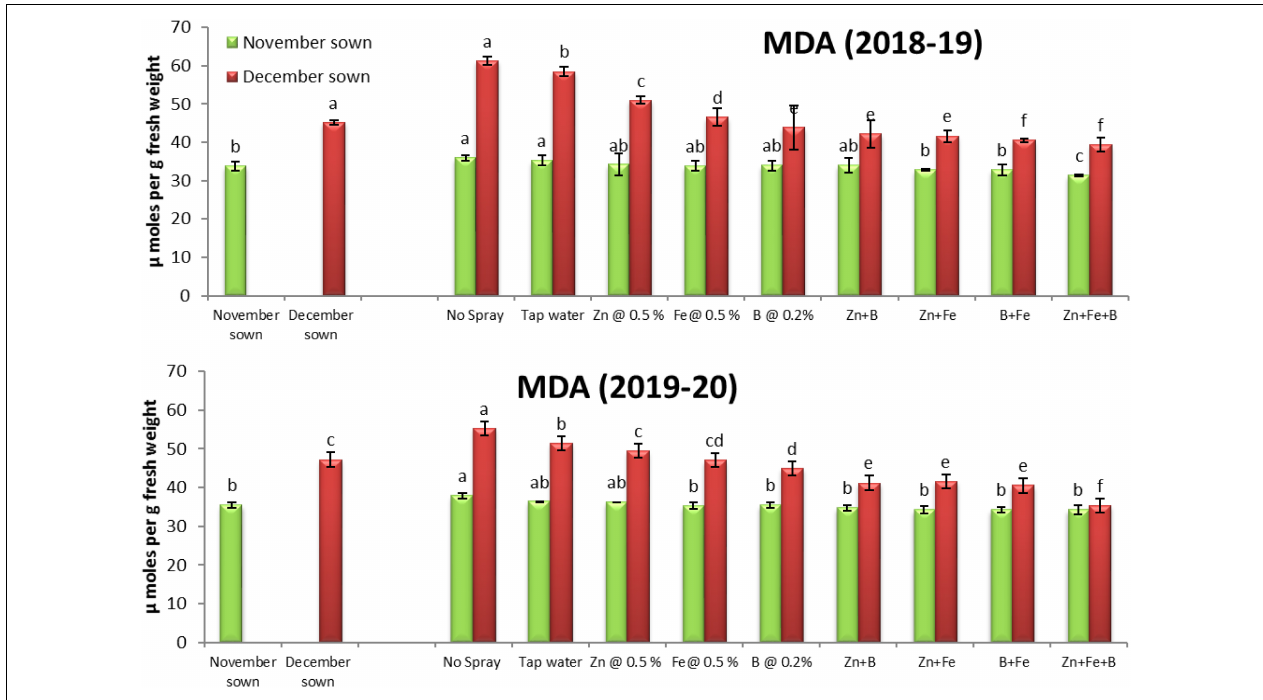
FIGURE 8 | Malondialdehyde (MDA; µ mol g - 1 FW) content for different sowing dates and foliar spray treatments in the 2018–19 and 2019–20 lentil cropping seasons. Values are means, and bars represent ± SEM ( n = 3). Different letters indicate significant differences between